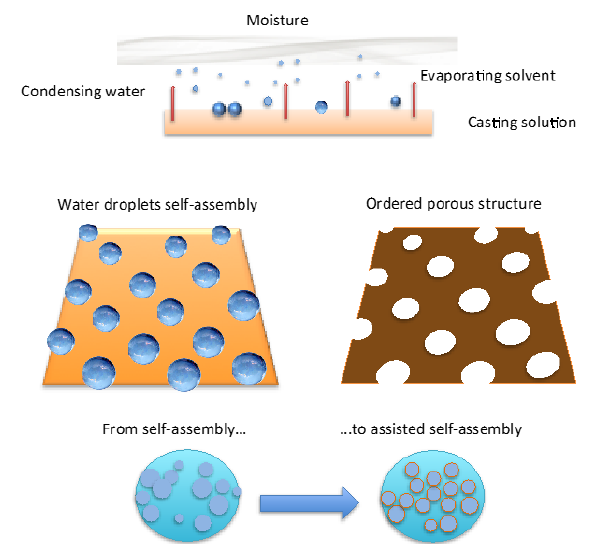
Figure 1. Representative scheme of formation of ordered porous membranes according to breath figure method.